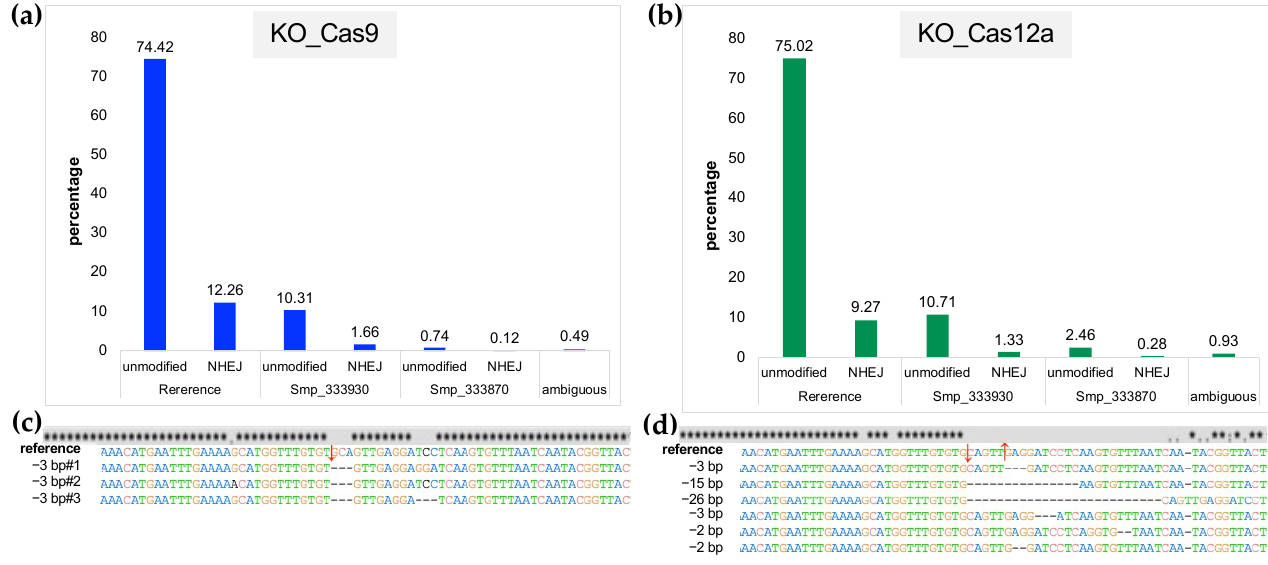
Figure 3. NHEJ assessment from S. mansoni eggs at the target ω 1 gene following delivery of Sp Cas9 and As Cas12a RNP complexes by electroporation: ( a – d ) CRISPResso2 analysis of the Illumina se- quence reads revealed nonhomologous end-joining (NHEJ) mutations at targeted loci in schistosome eggs. Allele-specific editing outcomes of CRISPR- Sp Cas9 and - As Cas12a gene editing in schistosome multiple copies of ω 1 Smp_334170.2, Smp_334170.1, Smp_334240 (100% gene sequence identical; Figure S1b). Mutagenesis frequencies for all loci including Smp_333930 and Smp_333870 were in- cluded in CRISPResso2 analysis (Figure S1b). The results were from NGS libraries of pooled genomic DNA from seven biological replicates of KO_Cas9 (panels a , c ) and KO_Cas12a (panels b , d ). The sequence reads assigned to reference genes, Smp_333930 and Smp_333870 loci, by the CRISPresso2 to achieve accurate quantification of programmed mutation of the multiple copies of ω 1 from Sp Cas9 and As Cas12a; ( a ) the bar chart shows the assignment of each read to the wild type (unmodified) and NHEJ with 12.26%, 1.66%, and 0.12% (total 14.04%) from KO_Cas9 on references and other two loci, respectively; ( b ) shows the assigned NHEJ with 9.27%, 1.33%, and 0.28% (total 10.88%) from KO_Cas12a on references and two highly identical copies of ω 1; ( c , d ) the majority of NHEJ indels from both nucleases were nucleotide substitutions followed by gene deletions; ( c ) Mutations were induced in all copies of ω 1; however, most editing was seen on the reference target site. Only deletions were revealed in this experiment, 3 nt deletion downstream from expected cut side (red arrow) was the majority of NHEJ mediated from Sp Cas9. The larger deletion from 2 to 26 nt at downstream of expected sticky end cut sites (red arrows) were revealed from NHEJ. CRISPResso2 interpreted ≤ 1.0% of the reads as ambiguous. Ambiguous alignments: 0.49% and 0.93% that could not be attributed uniquely to one of these loci are shown in the right-hand side bar of each graph. To estimate the frequency of HDR events, we included the donor sequence as a parameter in the CRISPResso2 analysis. More HDR events mediated by CRISPR/ Sp Cas9 were detected than with CRISPR/ As Cas12a; 17.07% vs. 14.56% and 12.37%, in similar fashion to our earlier findings [34]. However, in Sp Cas9 samples, more imperfect